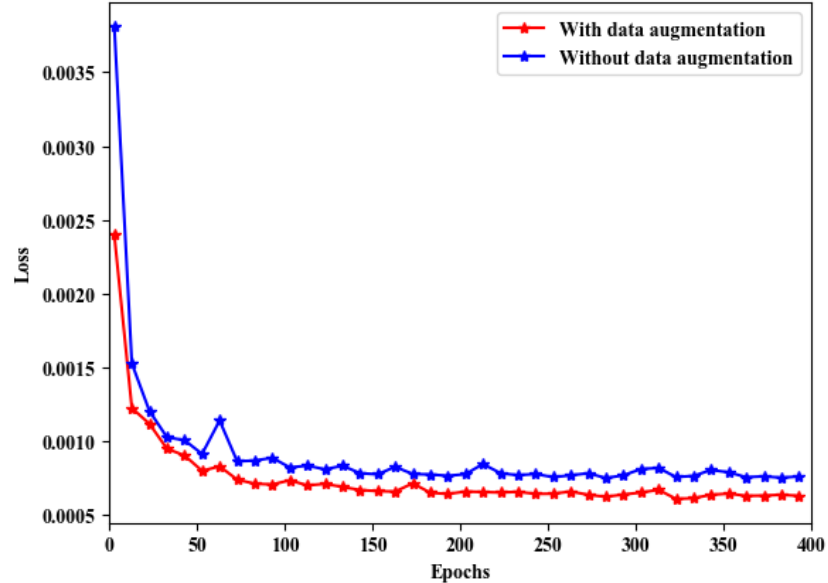
Figure 5. Training loss of the MCAE with/without data augmentation.